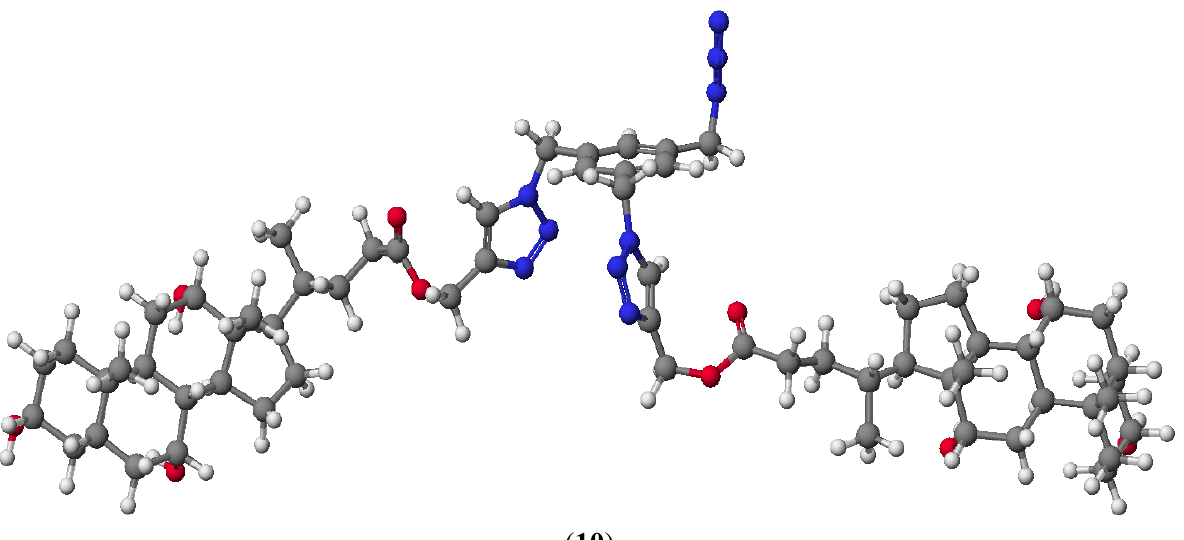
Figure 4. Molecular models of representative compounds 10 and 13 calculated by the PM5